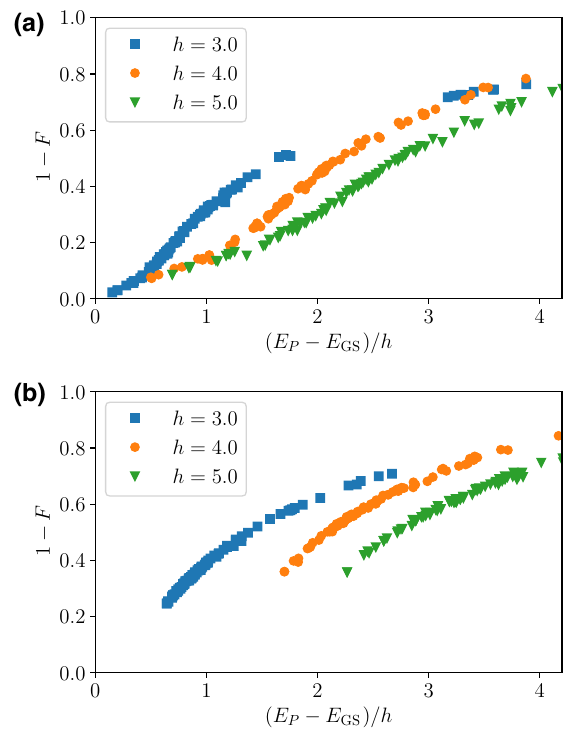
FIG. 17. Infidelity versus residual energy for 100 minima in the energy landscape found with random initialization of local BFGS searches, with | ψ 0 (cid:3) = | (cid:5) E (cid:3) and P = 6. Panel (a) cor- responds to the lattice with 4 × 4 plaquettes and panel (b) to 5 × 5 plaquettes. We only show the data that fall in the interval − E )/ h ∈ [0, ( E GS P